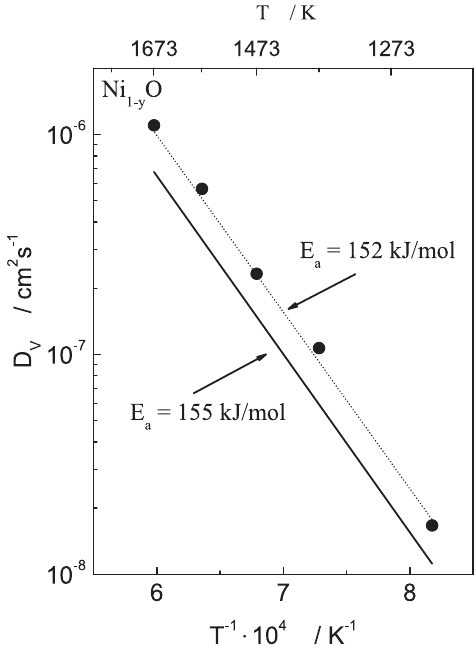
Fig. 2: Temperature dependence of the defect (vacancy) diffusion coefficient in Ni 1-y O, determined experimentally (symbols) on the background of calculated dependence, illustrated by the solid lines (Arrhenius